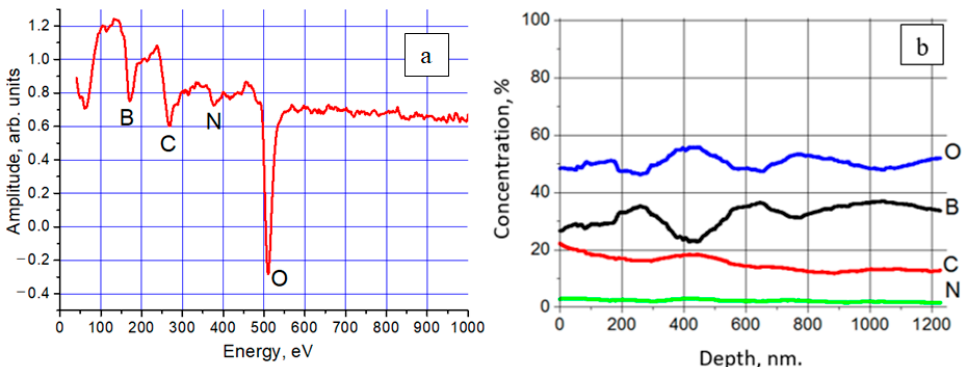
Figure 33. Elemental composition of the coating recorded using the Auger spectroscopy method from the sample surface ( a ) and its depth ( b ) [138].